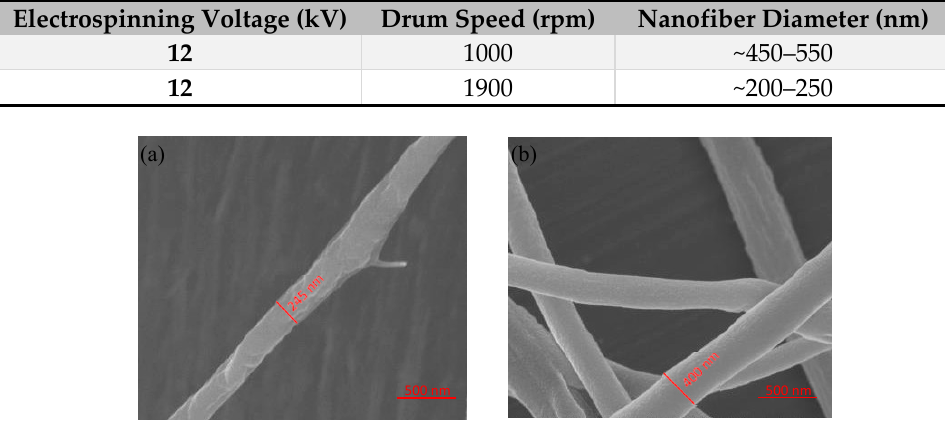
Table 2. Nanofiber diameters at different collector rotation